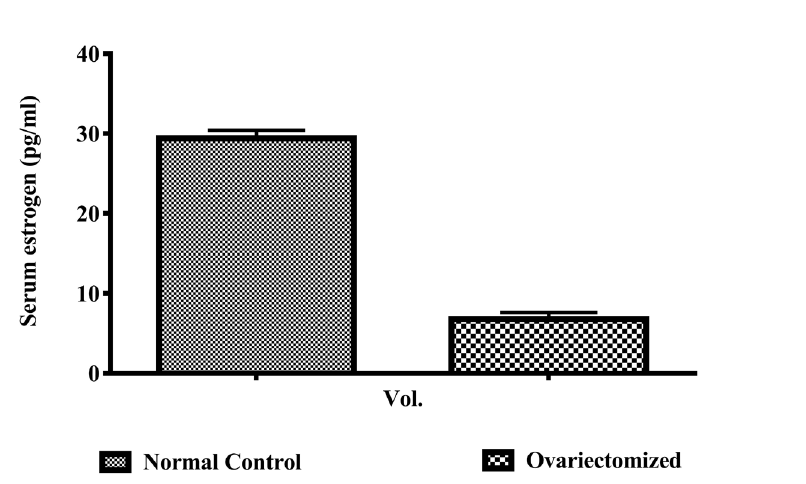
FIGURE 4 - Effect of ovariectomy on estrogen level. Values are expressed as mean ±S.D.